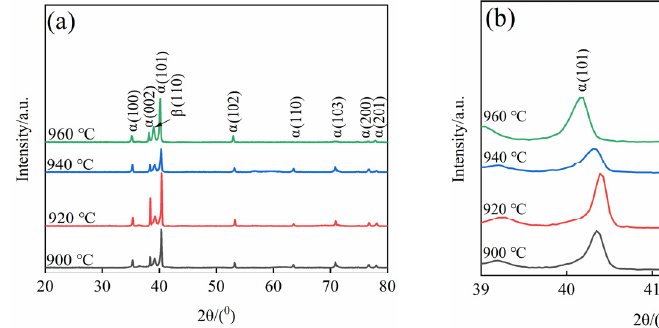
Figure 7. TEM morphology and selected area electron diffraction pattern: ( a ) α phase; ( b ) β phase. Figure 8 shows the microstructure of TC10 titanium alloy after different BASCA heat treatment. Compared with BASC heat treatment, the alloy undergoes an additional aging treatment, resulting in a more stable microstructure of the alloy. The overall change trend is consistent with BASC heat treatment. After BASCA heat treatment, the staggered region of some fine needle-like α phases can be seen between the lamellar α phases. This is be- cause during the aging process, the metastable β phase formed during BASC heat treat- ment will be decomposed to form smaller lamellar and needle-like α phases [20]. Com- pared with the BASC process at the BA temperature of 960 °C, many clusters are formed in all the original β grains, and the clusters scale is larger.